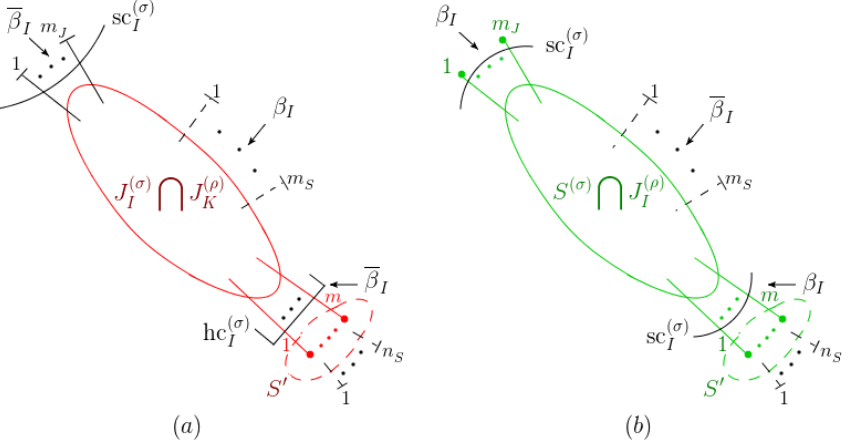
(cid:16) (cid:17) S T J ( (cid:26) ) (cid:17) J ( (cid:27) ) S 0 that is marked red in ( a ), and (cid:13) ( a ) I K